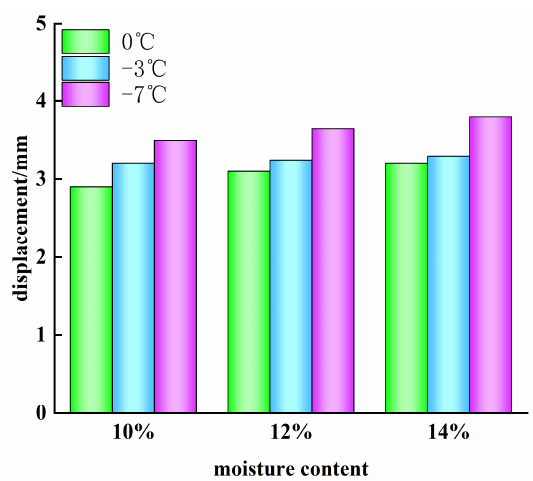
Figure 12. Horizontal displacement of the anchor rod at different temperatures.